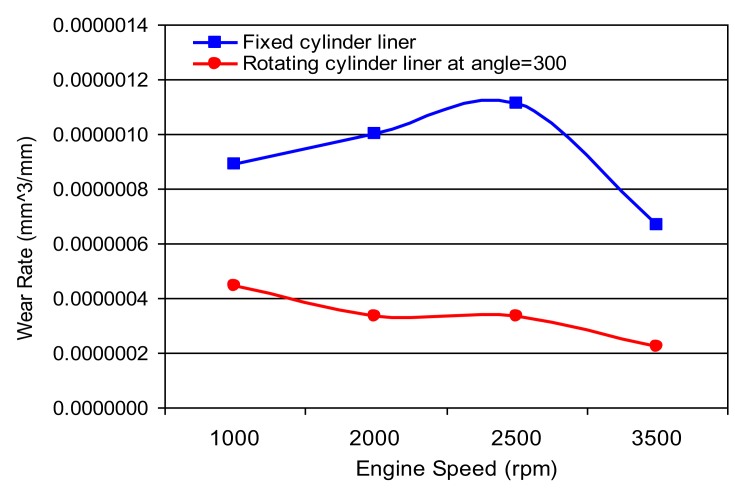
Wear rate of cylinder liner (rotating cylinder liner positioned at 300o angle.